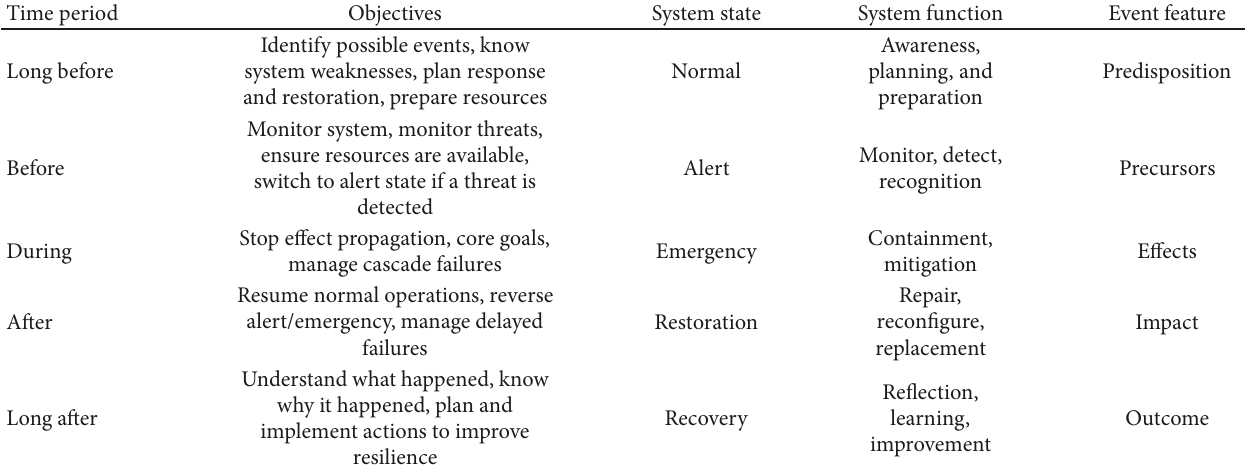
Table 5: A temporal outlook to disruptive events [8]. Relative to a disruptive event, resilience may be improved long before, before, during, after, and long after the